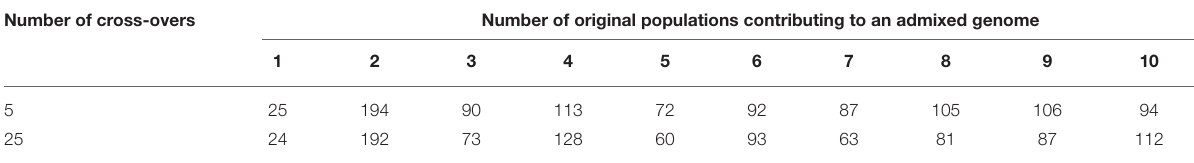
TABLE 2 | Summary of number of admixed persons with genome proportions of 1 to 11 original populations. Number of cross-overs